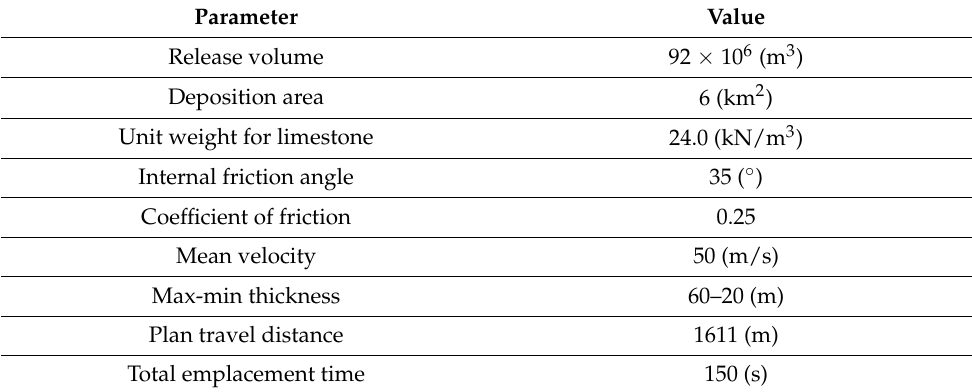
Table 2. Parameters used for run-out simulation and